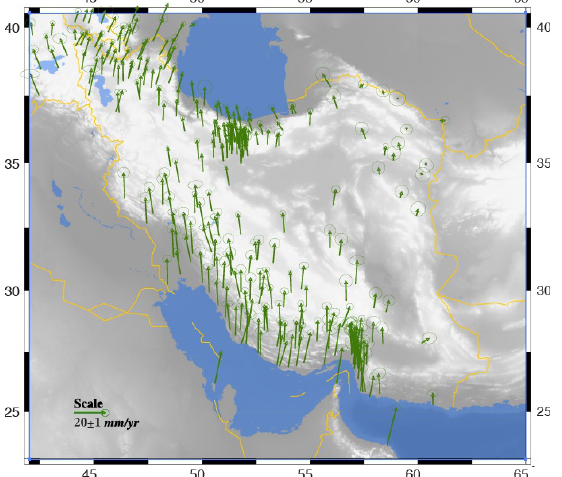
Figure 3. The combined velocity field for the region of Iran. A better coverage of geodetic data proper for further crustal defor- mation studies. A good coverage can be seen in Zagros, Alborz and Strait of Hormuz areas but the central and east- ern parts have almost no coverage. Confidence ellipses are 95%.